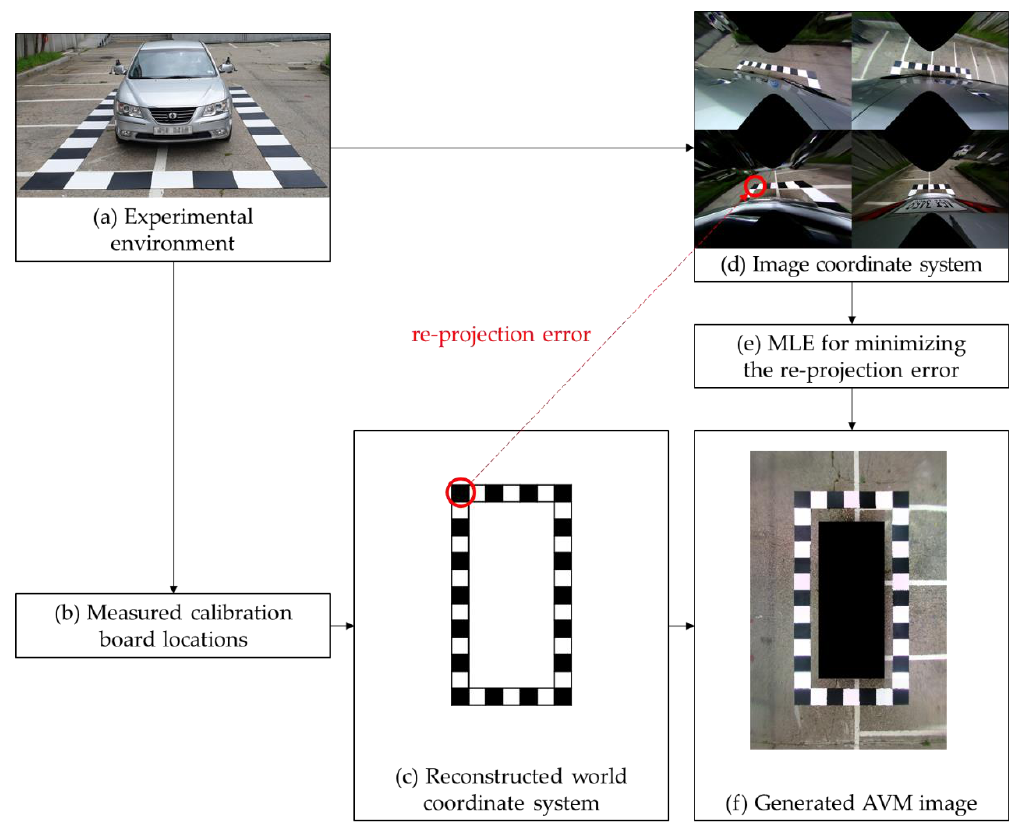
Figure 1. The procedure for conventional around view monitoring (AVM) calibration.